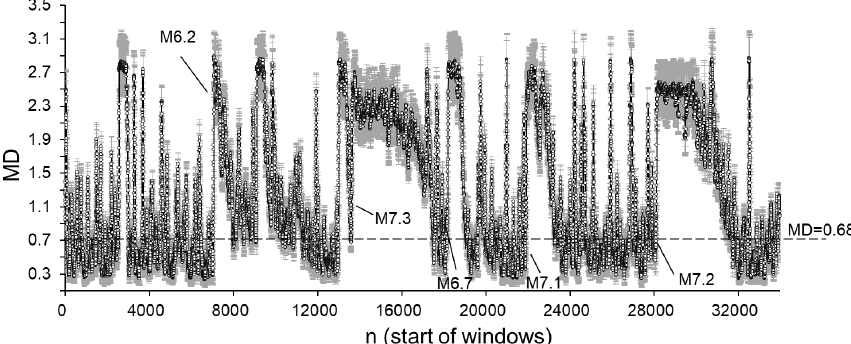
Figure 6. Average MD values calculated by comparing ICT( i ), ICD( i ), and ICE( i ) sequences from the original SC catalogue and from the set of randomised catalogues. The dotted line corresponds to a significant difference between windows at p = 0 . 01. MD values are calculated for 50 data windows shifted by one data